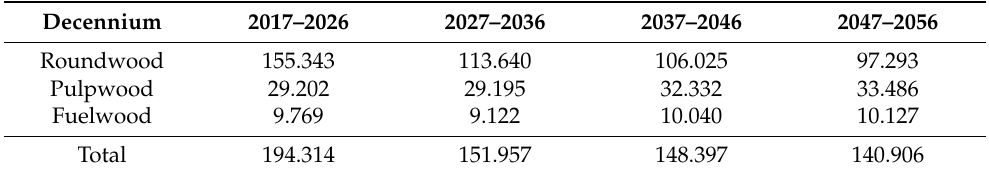
Table 1. Theoretical perspective of the possibilities of production of wood assortments in one decade for the period 2017–2056 (thousand m 3 up to 7 cm